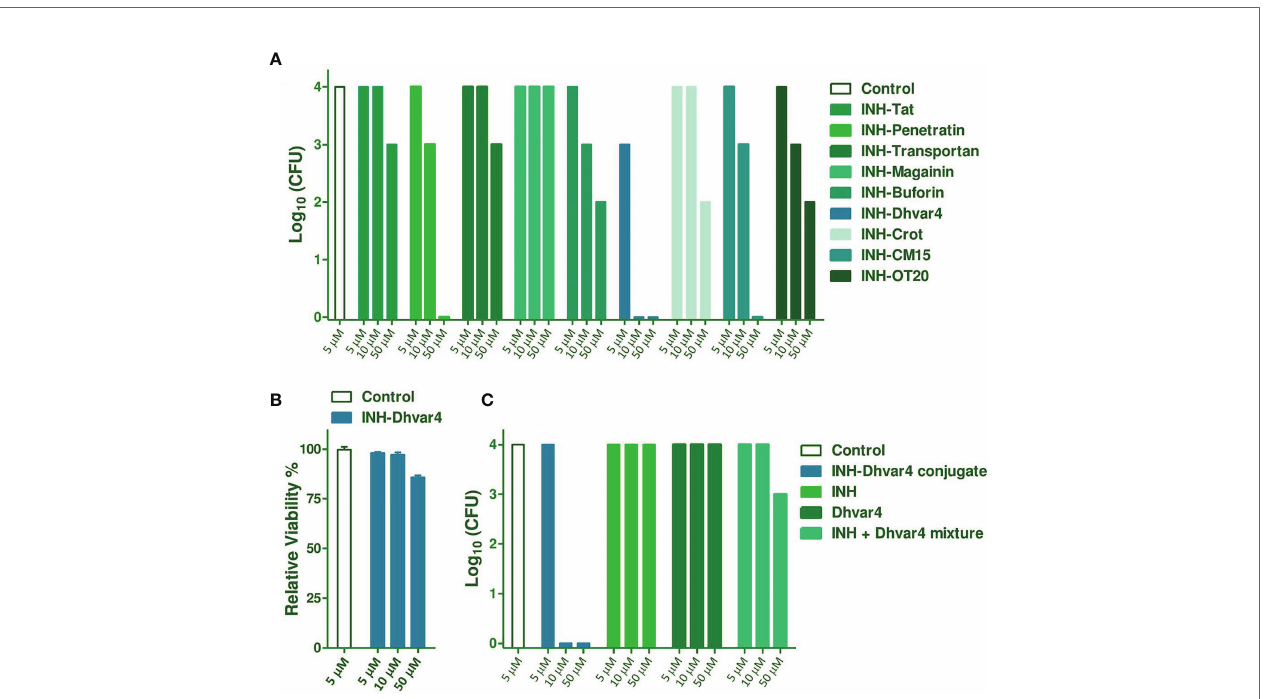
FIGURE 9 | Intracellular killing ef fi cacy of the INH-peptide conjugates was measured on Mtb H37Rv-infected MonoMac-6 cells (A) . Infected cells were treated with the conjugates at 5, 10, and 50 m M concentrations, two times for 3 + 3 days. After washing and SDS treatment, lysates were plated on Löwenstein-Jensen tubes and bacterial colonies were enumerated 4 weeks later. Cytotoxicity of INH-Dhvar4 to the host cell is presented in (B) . For a more detailed picture on the ef fi cacy against intracellular Mtb , INH, Dhvar4 alone, and in mixture was compared with the INH-Dhvar4 conjugate (C)